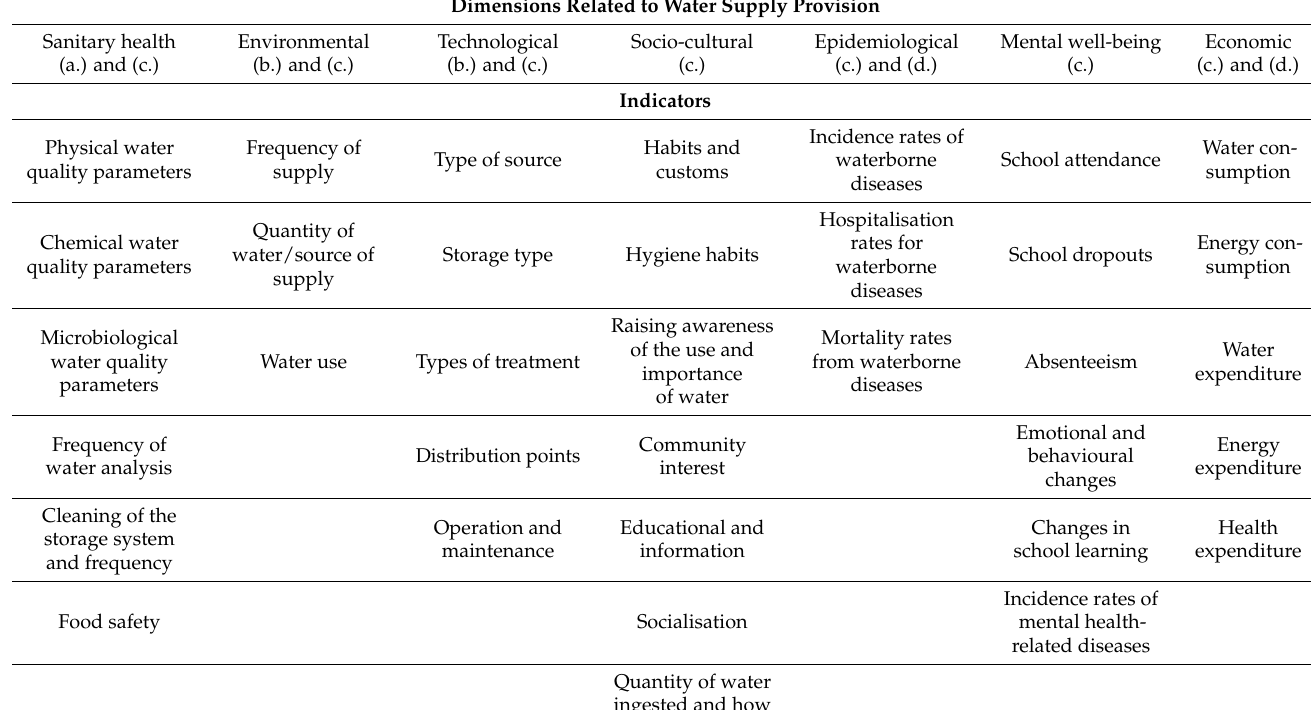
Table 2. A summary of the components and indicators related to water supply used in the HIA showing impacts on health. Where (a.) to (d.) relate to the evaluation tools given in Section 4. Dimensions Related to Water Supply